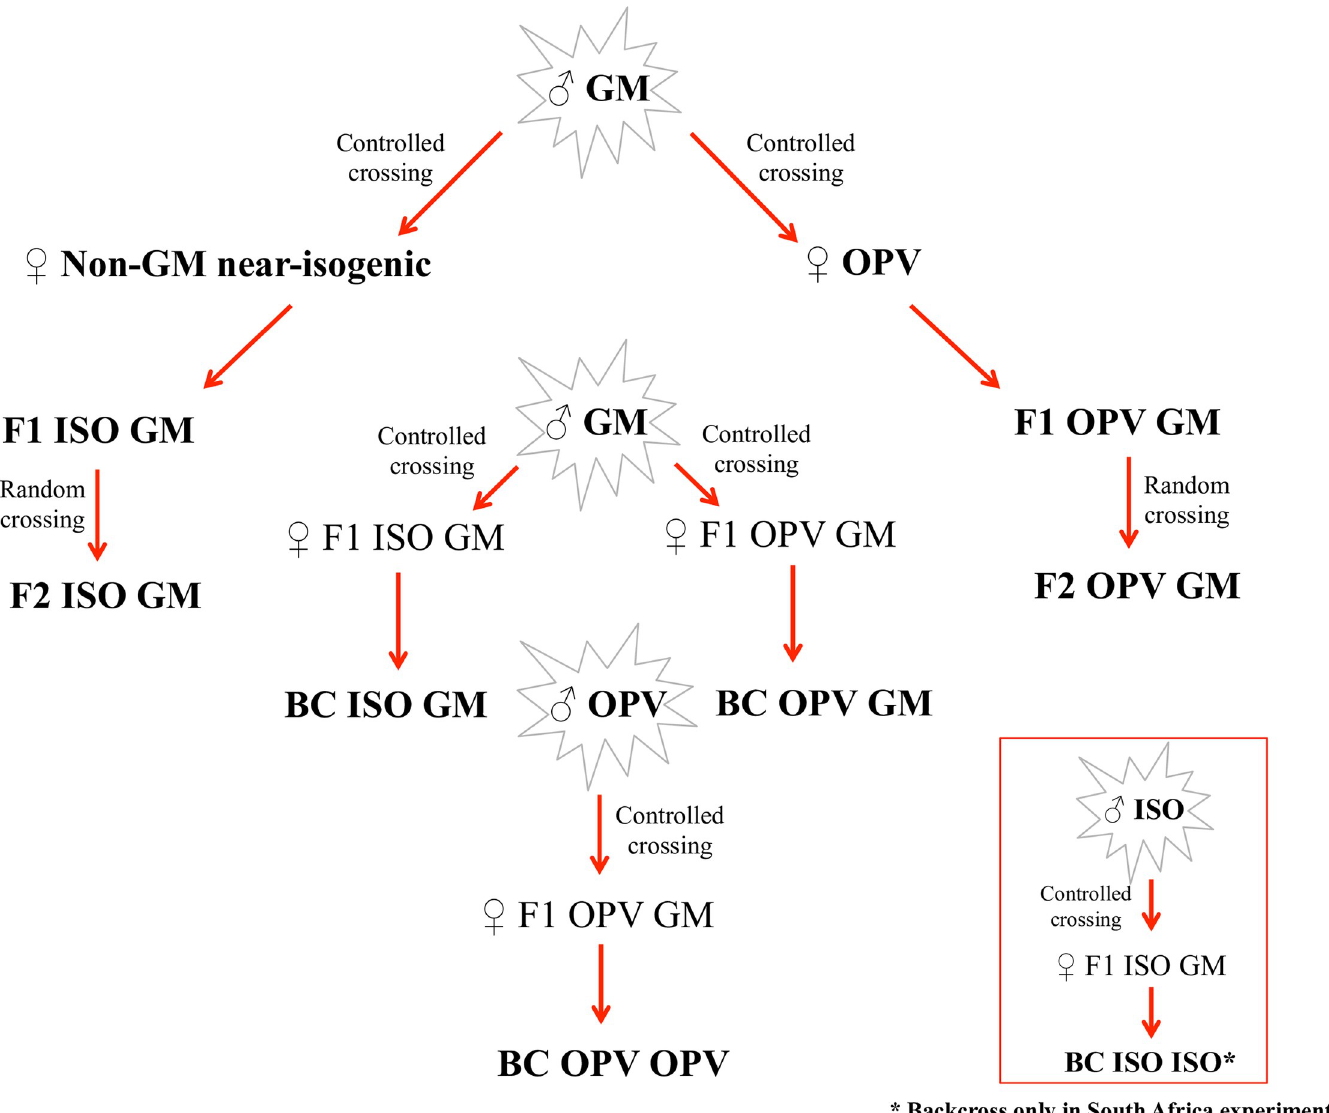
Fig 1. Diagram indicating how the crosses and backcrosses from Brazil and South Africa were obtained.